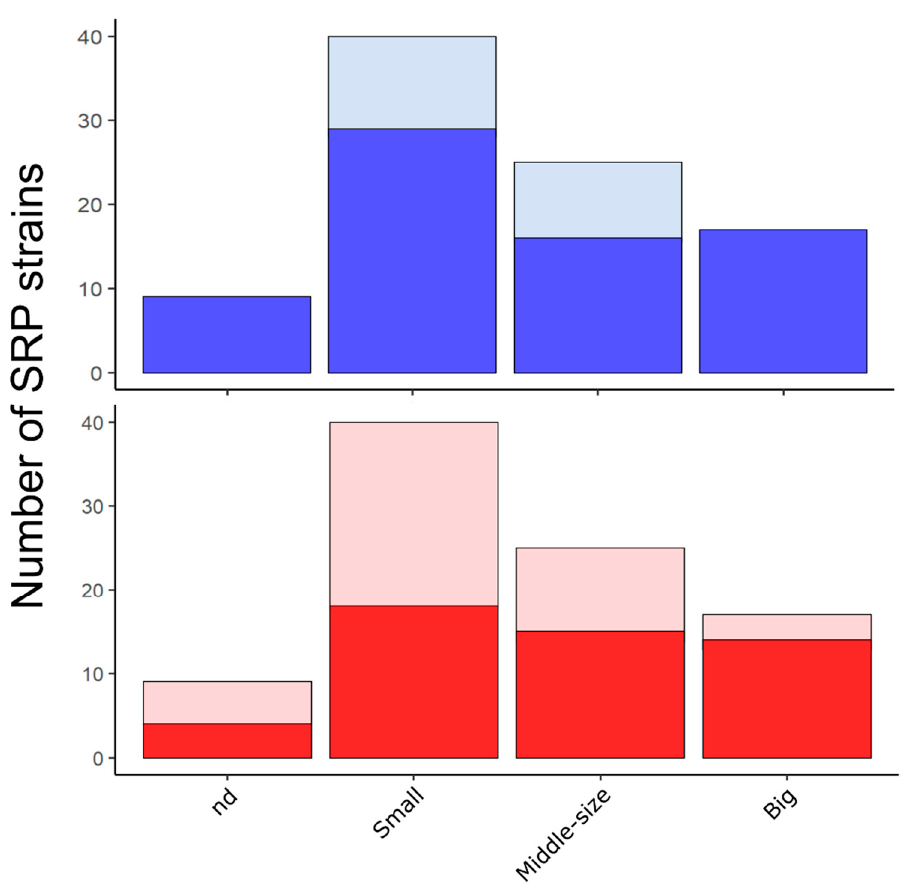
Figure 4. Distribution of CRISPR ( top ) and prophages ( bottom ) in different cell sizes. The top chart shows SRP that contain CRISPR (blue) and do not contain CRISPR (light blue). In the lower chart, lysogenic and non-lysogenic SRP are shown in red and light red, respectively.